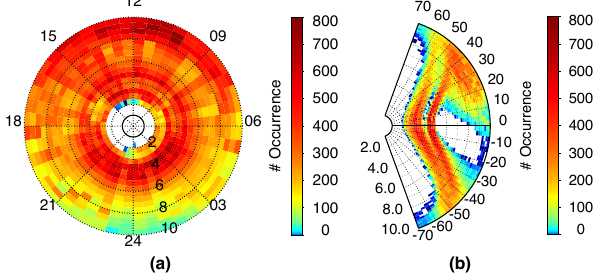
Fig. 4. Distribution of the electron density measurements gathered after analysis of 1373 validated perigee passes. (a) L -MLT view of the occurrence summed up inside magnetic flux tubes of section 0.5 in L and 0.5h in MLT. (b) L -MLat view of the occurrence summed up over all MLT sectors, for cells of dimension 0.2 in L over